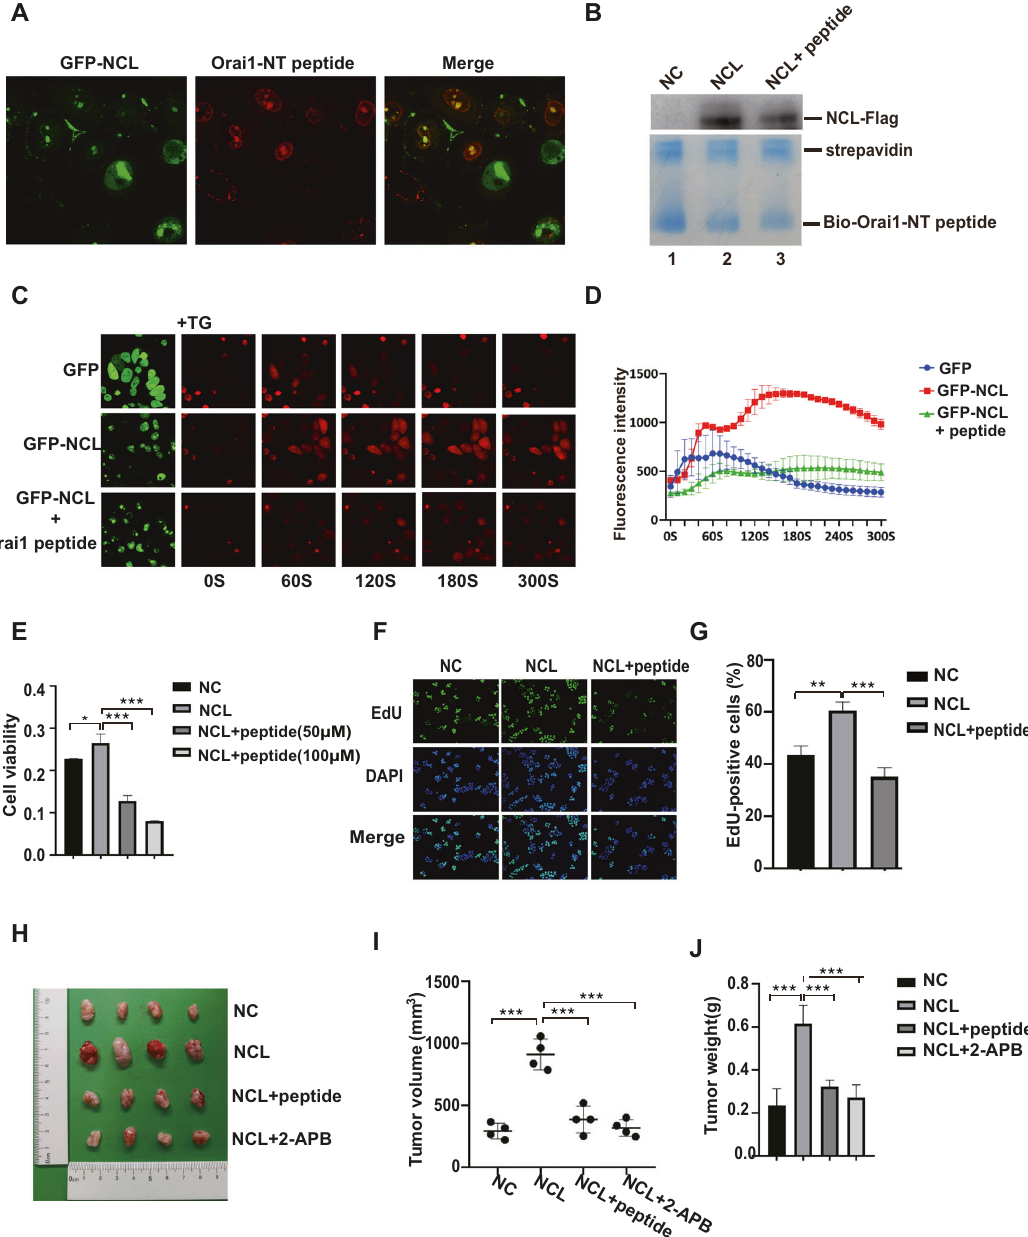
Fig. 6 Blocking the interaction between NCL and Orai1 with Orai1 peptide inhibited breast cancer cells proliferation in vitro and in vivo. A Co-localization of GFP-NCL (green) with rhodamine-labeled TAT-Orai1-NT peptide (red). MCF-7 cells transfected with GFP-NCL were incubated with Orai1 peptide for 1 h, then the cellular co-localization of TAT-Orai1-NT peptide and NCL was detected with confocal microscopy. B Biotin-based peptide pulldown assay to determine peptide-blocking effect of interaction between NCL and Orai1. MCF-7 cells transfected with NCL-Flag plasmid were incubated with the cell-penetrating TAT-Orai1-NT peptides. The cell lysate was bound with biotinylated Orai1-NT peptides immobilized on streptavidin beads and precipitated NCL proteins were detected by western blotting using anti-Flag antibody. C , D Measurement intracellular calcium in fl ux using confocal microscopy in MCF-7 cells transfected with GFP-NCL and treated with Orai1-NT peptide. E MTT assay to assess the effect of Orai1-NT peptide on the proliferation of MCF-7 cells stable expression of NCL. F , G EdU staining for evaluation of the in fl uences of Orai1 peptide on the proliferation of breast cancer cells stable expression of NCL. H Subcutaneous xenograft tumor growth in nude mice was measured. MCF-7 cells stable expression of NCL and negative control cells were transplanted to BALB/c nude mice. Mice were treated with Orai1 peptides or 2-APB. Tumor volume and weight were measured ( I , J ). All data are shown as mean ± SD. of three replicates. * P < 0.05. ** P < 0.01. *** P <